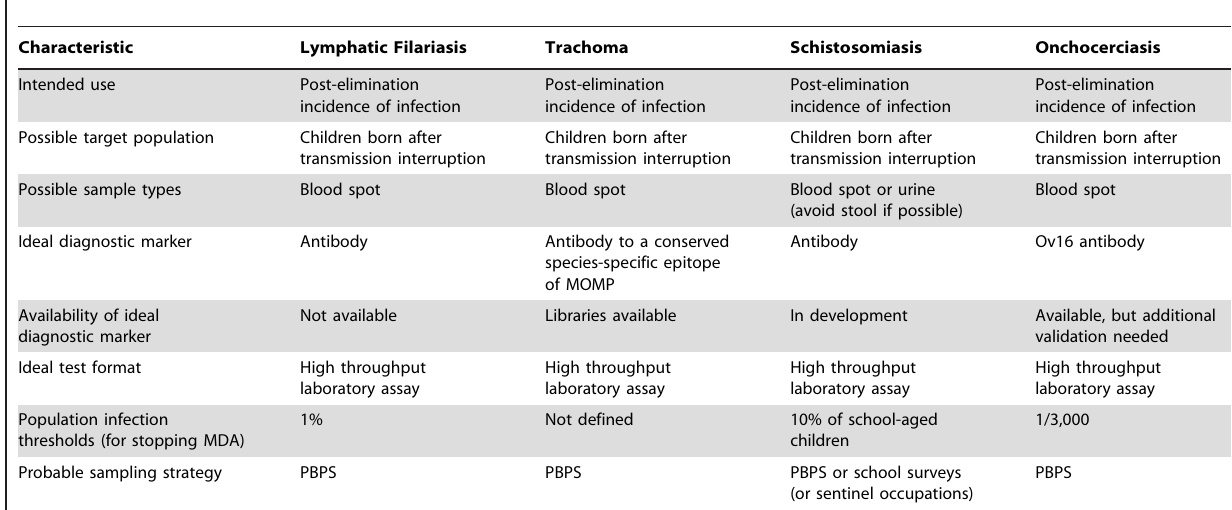
Table 2. Proposed target product profiles for diagnostic tools for selected NTDs, post-elimination surveillance. a